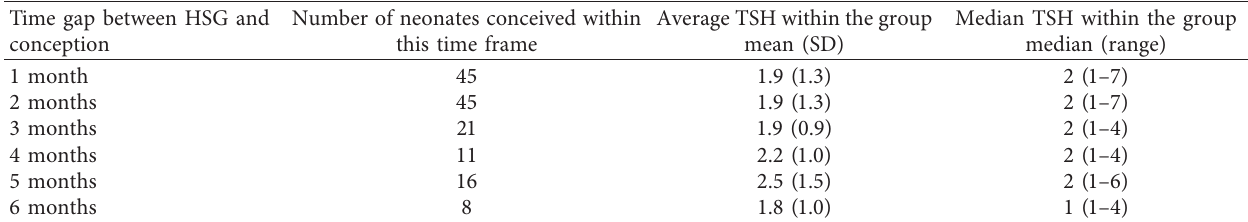
Table 3: TSH distribution of neonates conceived within various time frames after the OSCM